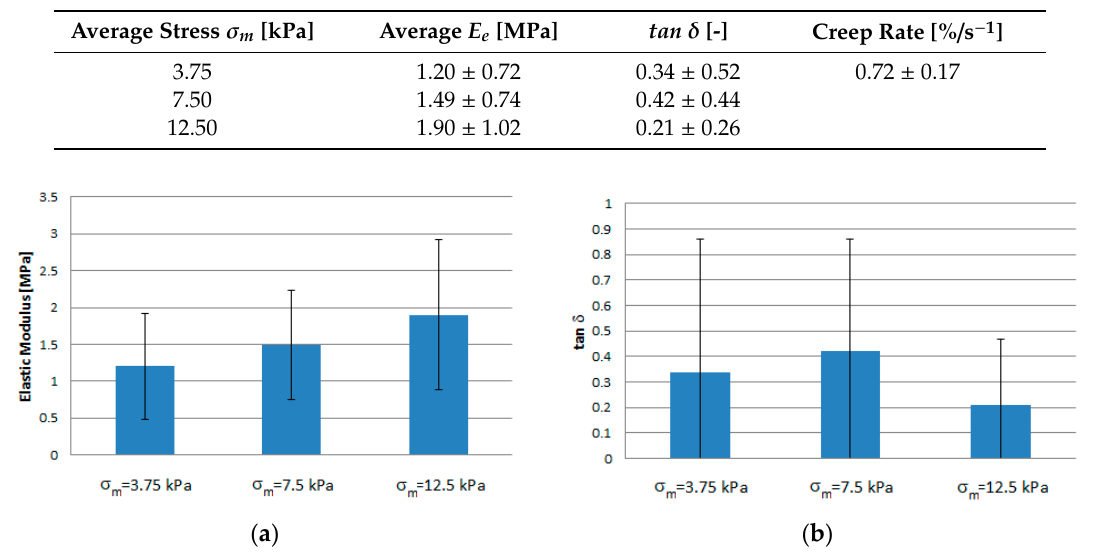
Table 1. Mechanical properties of cortical ovarian tissue.